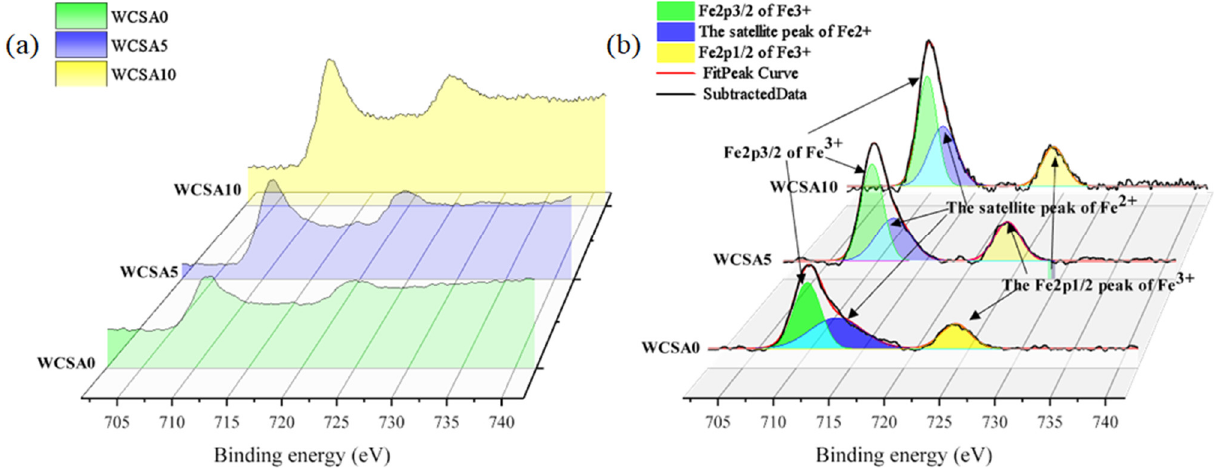
Figure 7. Fe2p spectra for WCS: WCSA0, WCSA5, and WCSA10; ( a ) original spectra and ( b ) decon- volved peaks.